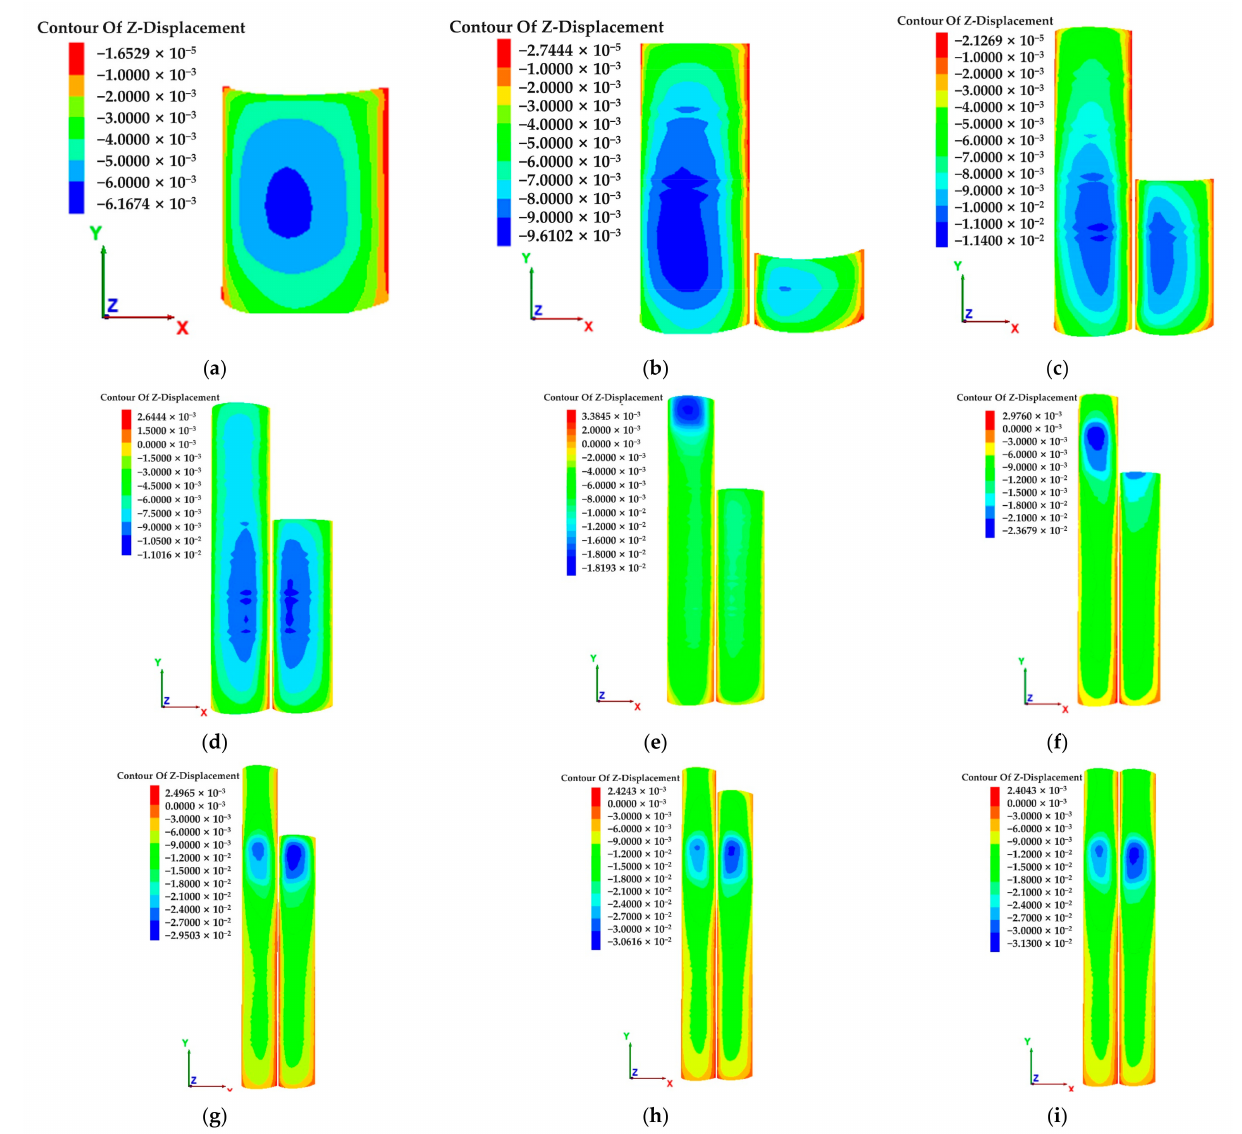
Figure 17. Vertical deformation of vault lining during main tunnel excavation (unit: m): ( a ) L = 20 m; ( b ) L = 40 m; ( c ) L = 60 m; ( d ) L = 80 m; ( e ) L = 100 m; ( f ) L = 120 m; ( g ) L = 140 m; ( h ) Excavation of right tunnel to 130 m; ( i ) The main tunnel excavation is